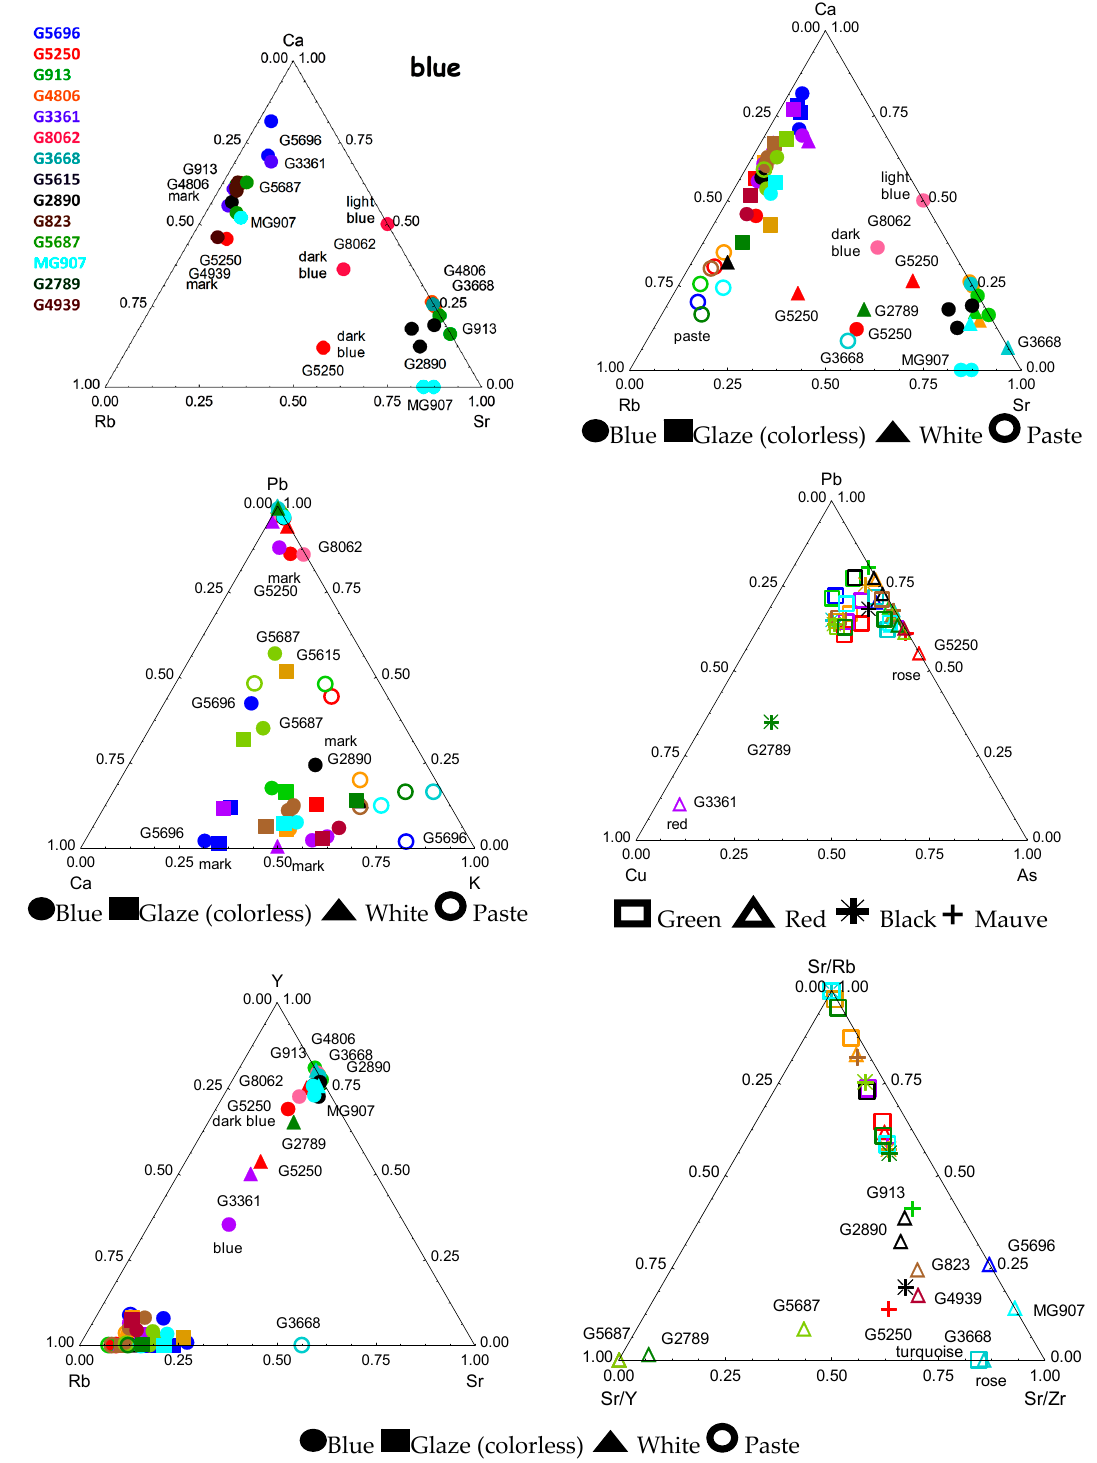
Figure 5. Comparison of the signal of flux elements (Pb, Ca, K) of matrices of blue, white or colorless, green, rouge/pink/mauve enamels and pastes and associated elements (Sr, R, Y) (Coll. mnaa-Guimet). The inventory numbers are given; the color of the symbol is that of the enameled area. The Ca-Rb-Sr ternary diagram (Figure 5) constructed from ‘blue’ enamels highlights